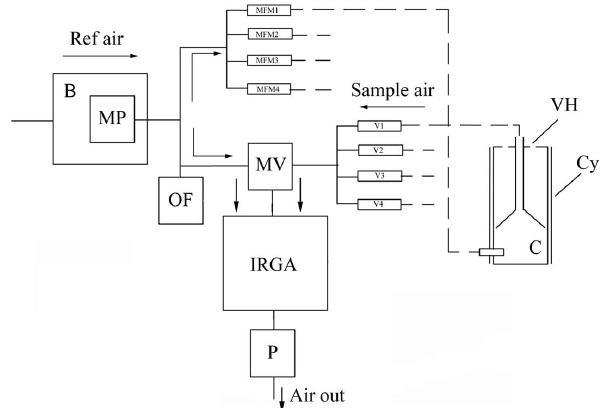
Fig. 1. Schematic air-flow diagram of the system (B: buffer vol- ume, MP: main pump, P: sampling pump, OF: overflow, MFM1-4: mass flowmeters, MV: main valve, V1-4: valves, VH: vent holes, C: chamber with a funnel, Cy: metal cylinder, IRGA: gas analyzer, Ref air: reference air flow, Sample air: sample air flow, Air out: air outlet from the